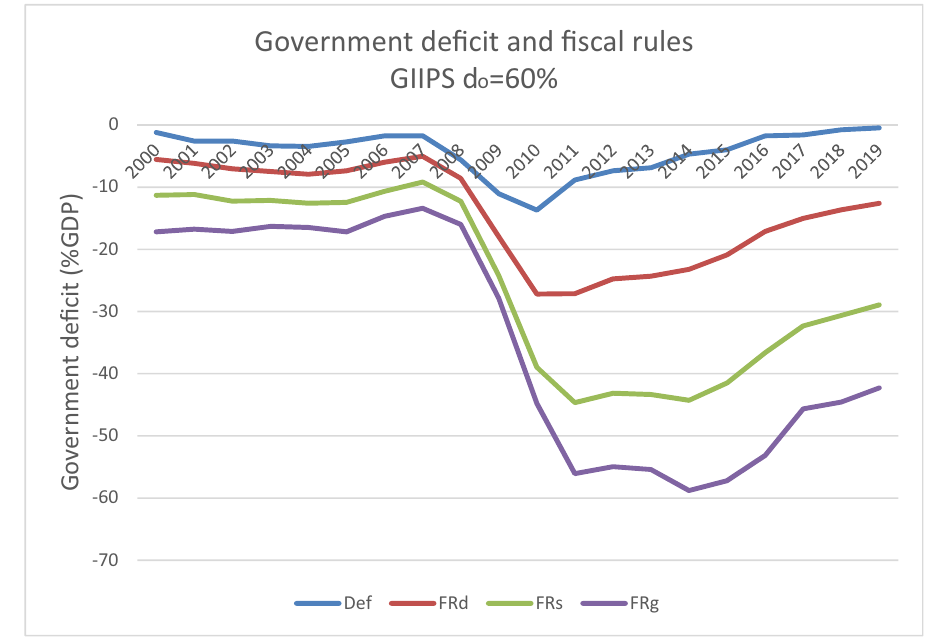
Figure 2.4: GIIPS countries government de fi cit ( Source: Own elaboration from data on Table 2 ) .